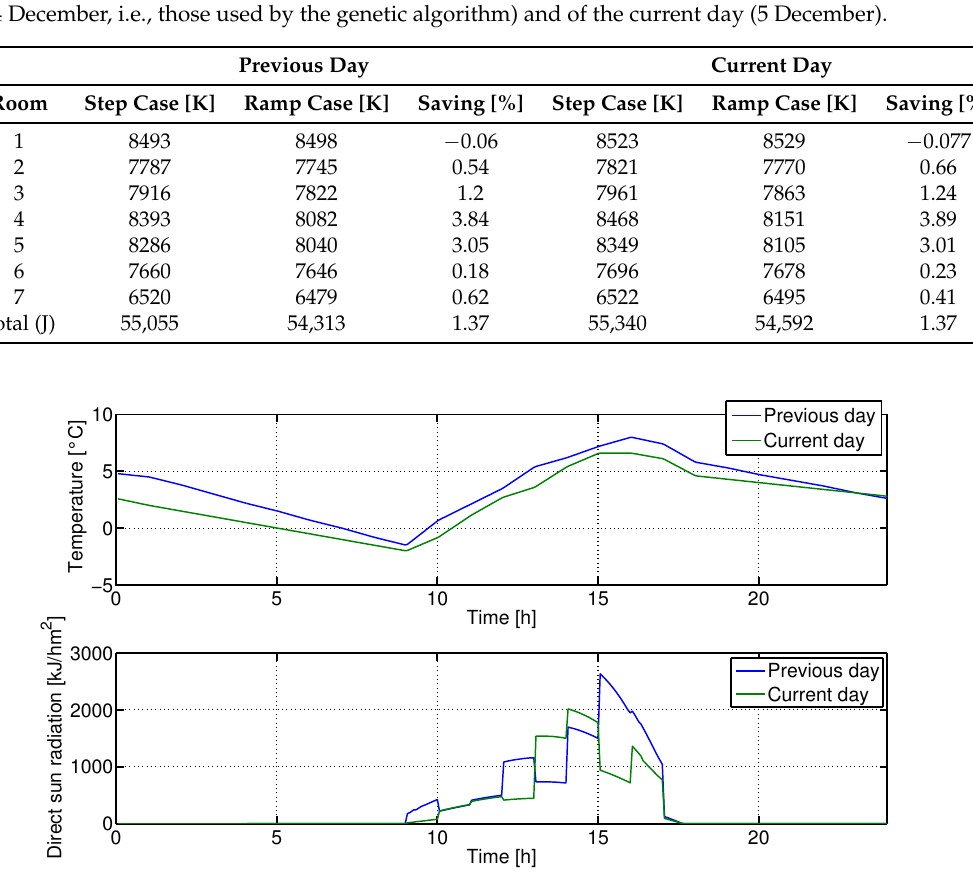
Figure 10. External temperature and solar radiation in the two days considered for the simulation results, 4–5 December. Blue line: previous day. Green line: current